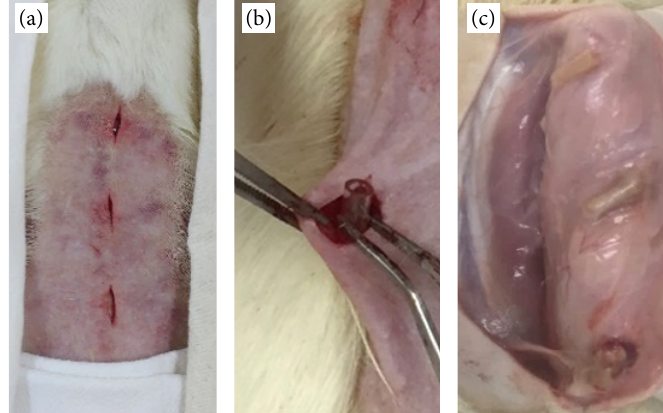
Figure 1 - (a) Incisions made in the dorsal region of the rat to implant